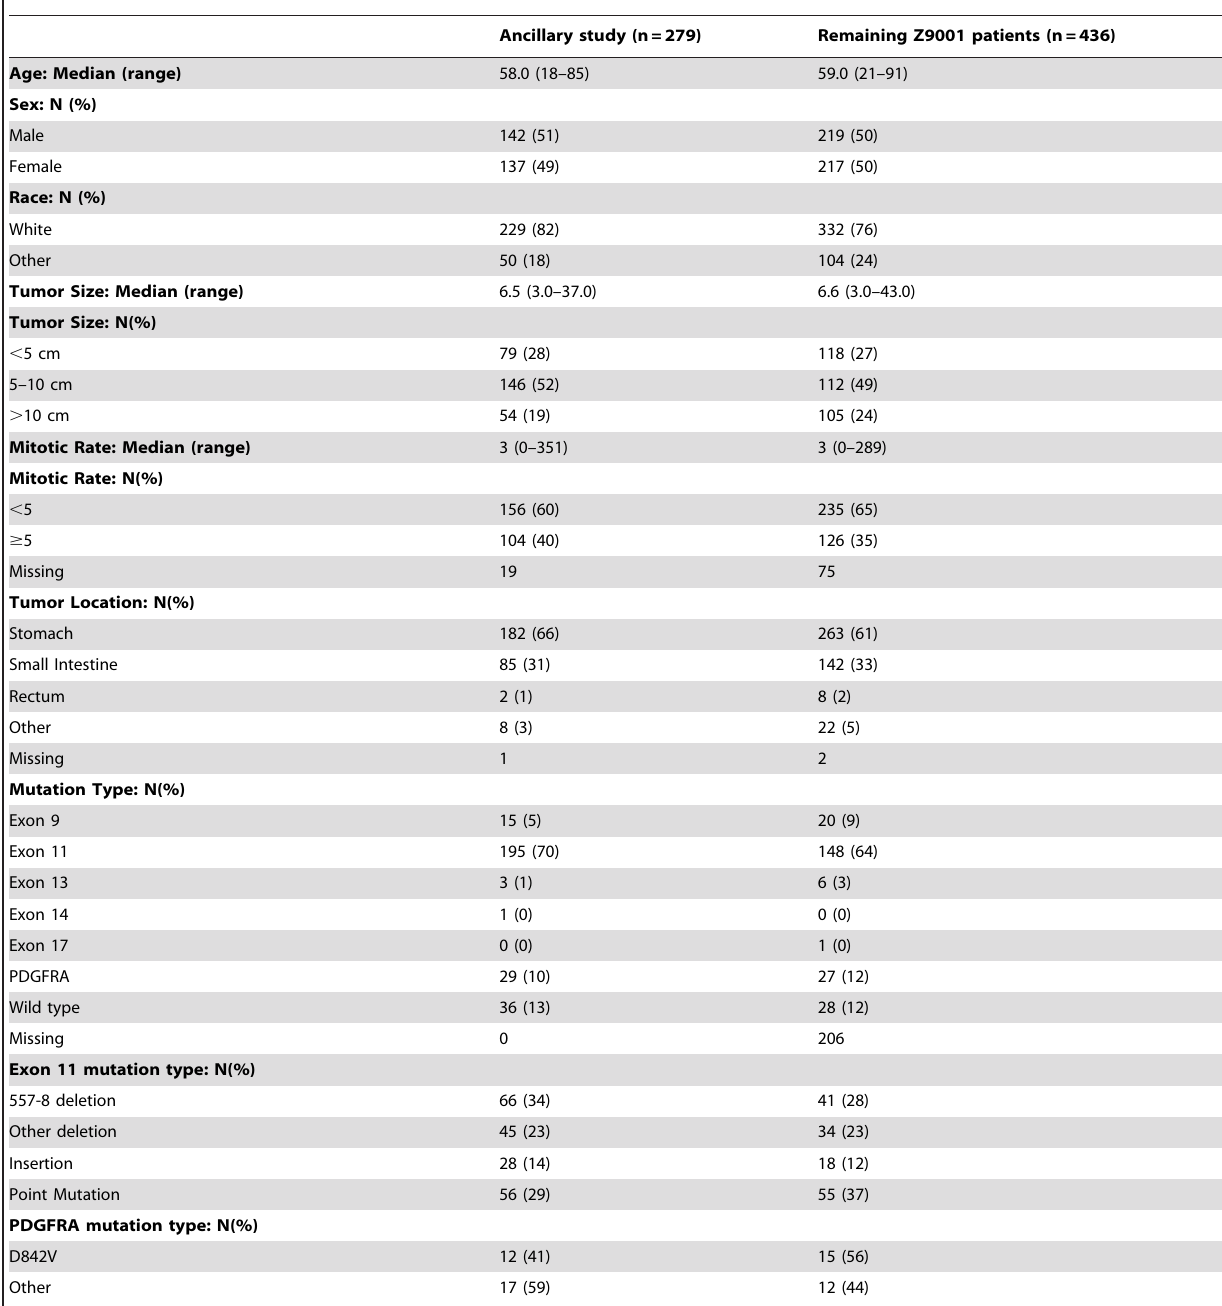
Table 2. Comparison of patients included in the genetic ancillary study to the remainder of the Z9001 clinical trial patients.